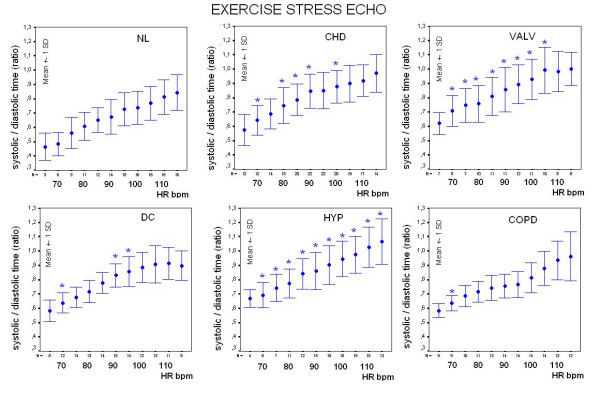
Exercise stress, controls vs. patients. Systolic/diastolic ratio plotted against heart rate in 17 controls (NL, left upper panel) and in patients groups during exercise stress. At each stage of exercise inter-group comparison was performed and significant differences (p < 0.05) are displayed with symbols: * = significant differences between controls and patients groups.